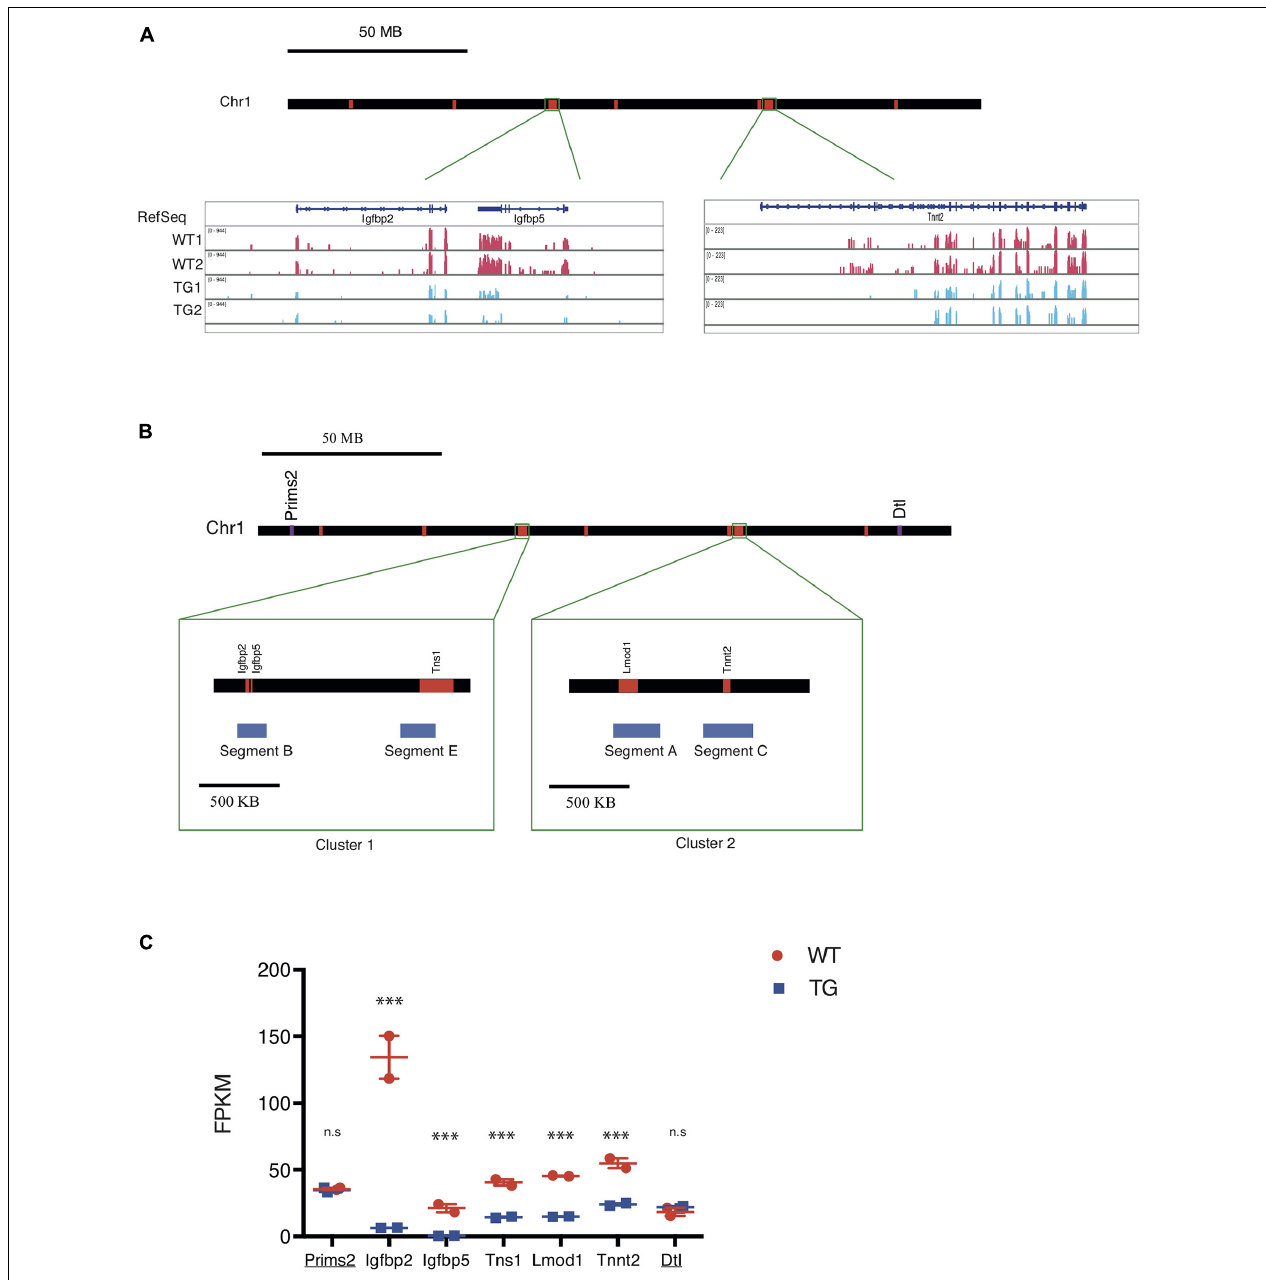
FIGURE 3 | The Xic transgene induces transcriptional repression of genes clustered on chromosome 1. (A) Map of mouse chromosome 1 with regions of down-regulated genes labeled in red. Representative RNA-seq tracks showing transcripts in WT and TG fibroblast samples for three genes, Igfbp2, Igfbp5 , and Tnnt2 , which are located in two chromosomal regions. (B) Map of mouse chromosome 1 showing two clusters of down-regulated genes. Cluster 1 spans Chr1: 72, 824, 480-74, 124, 449; Cluster 2 spans Chr1: 135, 301, 535-136, 178, 014. Within Cluster 1, Segment B and Segment E correspond to transcriptionally repressed genes Igfbp2 / Igfbp5 and Tns1 , respectively; whereas in Cluster 2, Segment A and Segment C correspond to transcriptionally repressed genes Tnnt2 and Lmod 1 , respectively. Two genes, Prims2 and Dtl (labeled in purple), are located distal to the down-regulated genes (labeled in red) arranged in the chromosome. (C) FPKM values for the seven genes along the chromosome with their expression detected in WT (red) and TG (blue) cell samples by RNA-seq. Prims2 and Dtl (underlined) are located outside of Clusters 1 & 2 that include Igfbp2 , Igfbp5 , Tns1 , Lmod1 , and Tnnt2 . n.s., not significant; ∗∗∗ p <